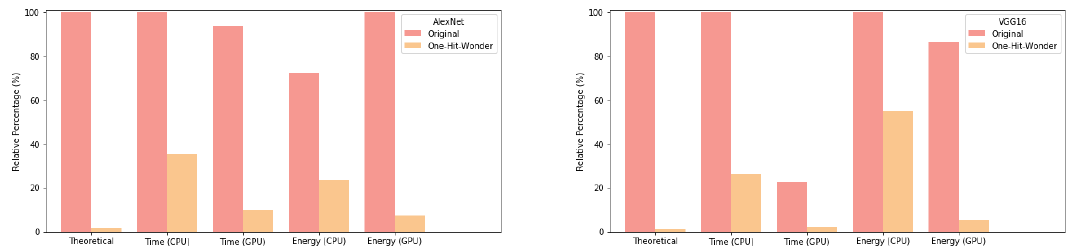
Figure 9. Comparison of layers between original and pruned version of both AlexNet and VGG16 on the SUN397 dataset.